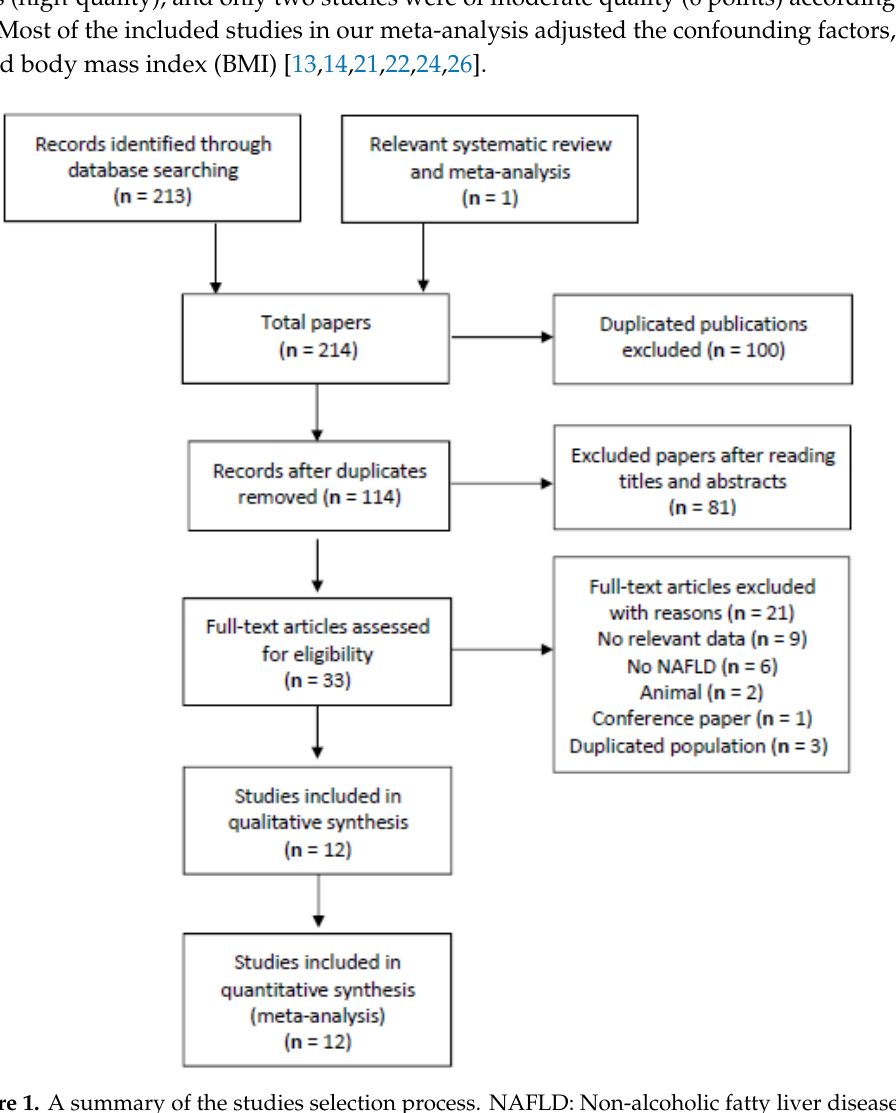
Figure 1. A summary of the studies selection process. NAFLD: Non-alcoholic fatty liver disease.